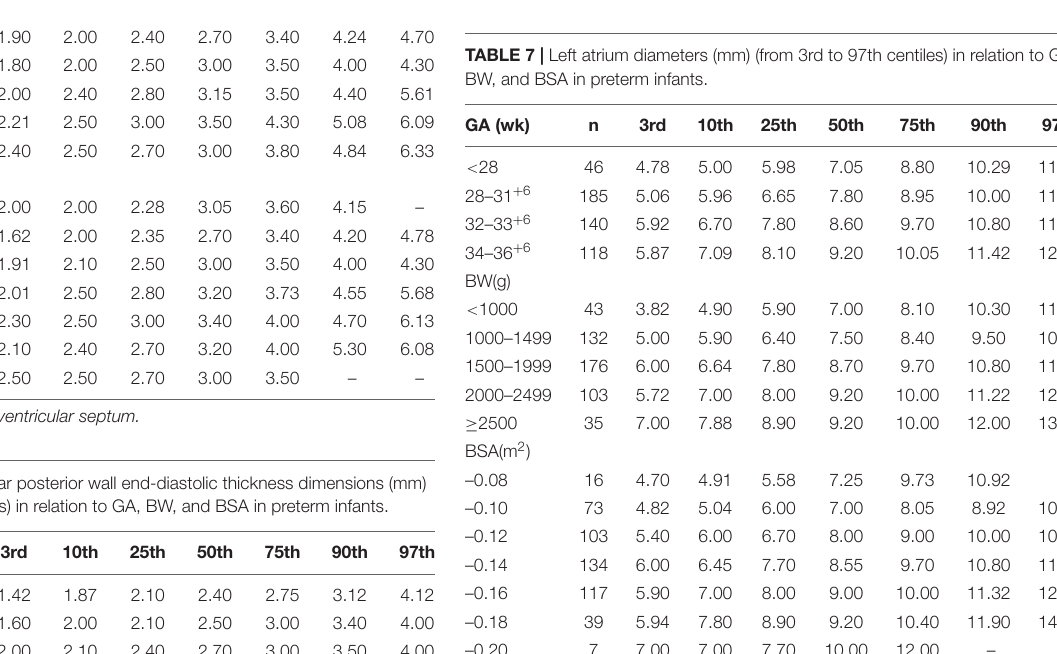
TABLE 5 | End-diastolic interventricular septum dimensions (mm) (from 3rd to 97th centiles) in relation to GA, BW, and BSA in preterm infants.